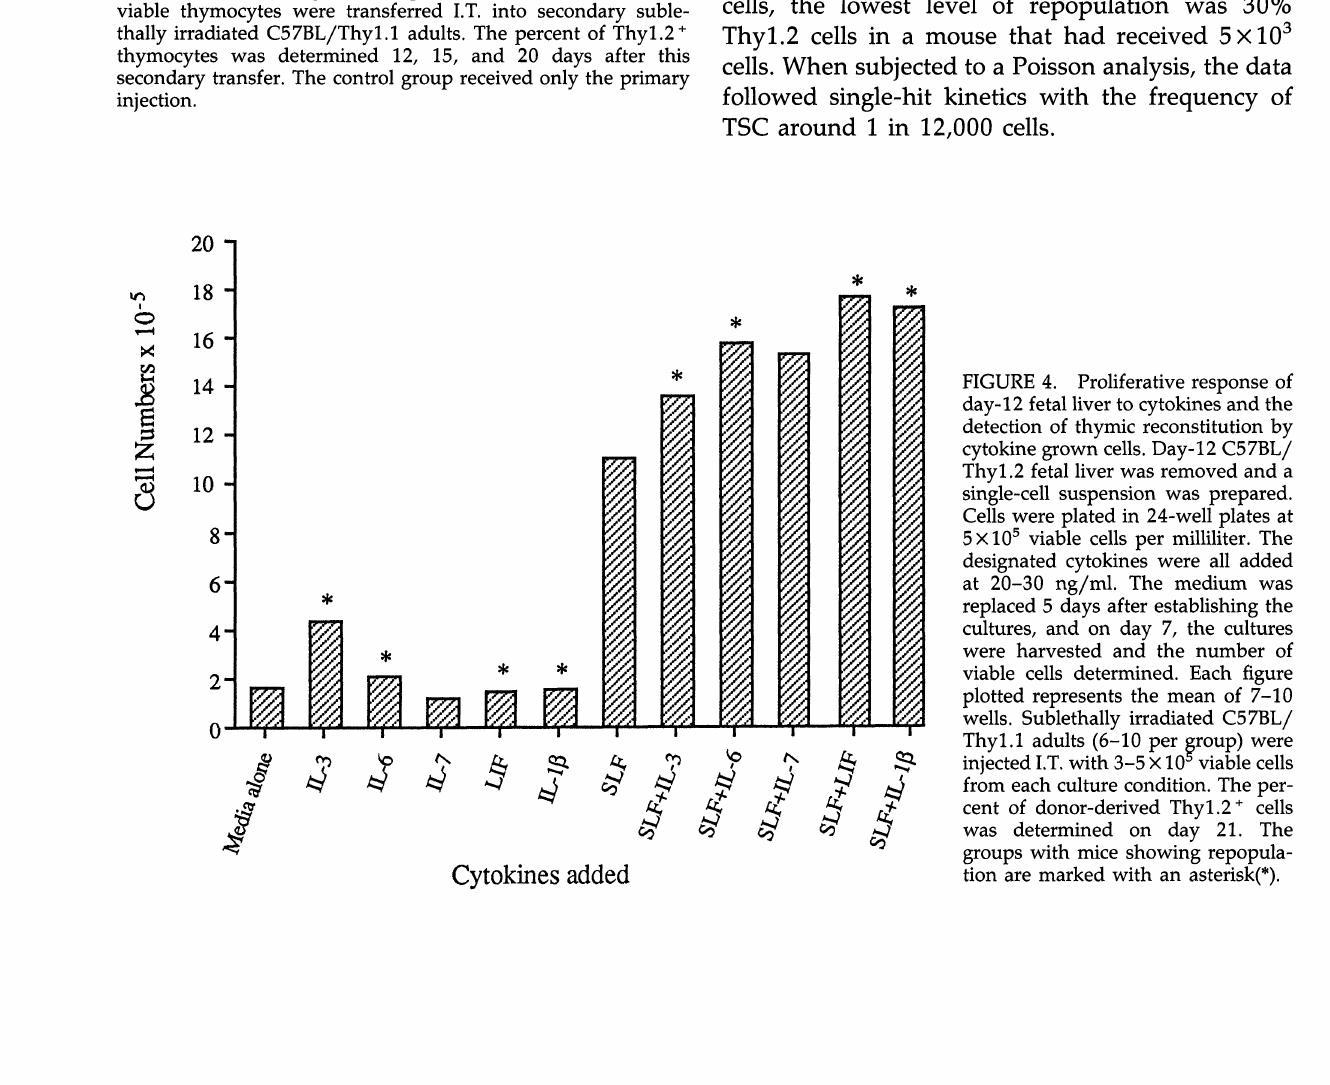
FIGURE 3. The loss of reconstitution potential of thymic stem cells. C57BL/Thy1.1 adult mice were sublethally irradiated and 3 hr later were injected I.T. with lx106 day-12 C57BL/Thy1.2 fetal liver cells. At designated times (1, 8, 24, and 48 hr after this primary injection), the mice were sacrificed and the injected lobes were removed. A single-cell suspension was made and 5 x 10 viable thymocytes were transferred I.T. into secondary suble- thally irradiated C57BL/Thy1.1 adults. The percent of Thyl.2 thymocytes was determined 12, 15, and 20 days after this secondary transfer. The control group received only the primary injection.